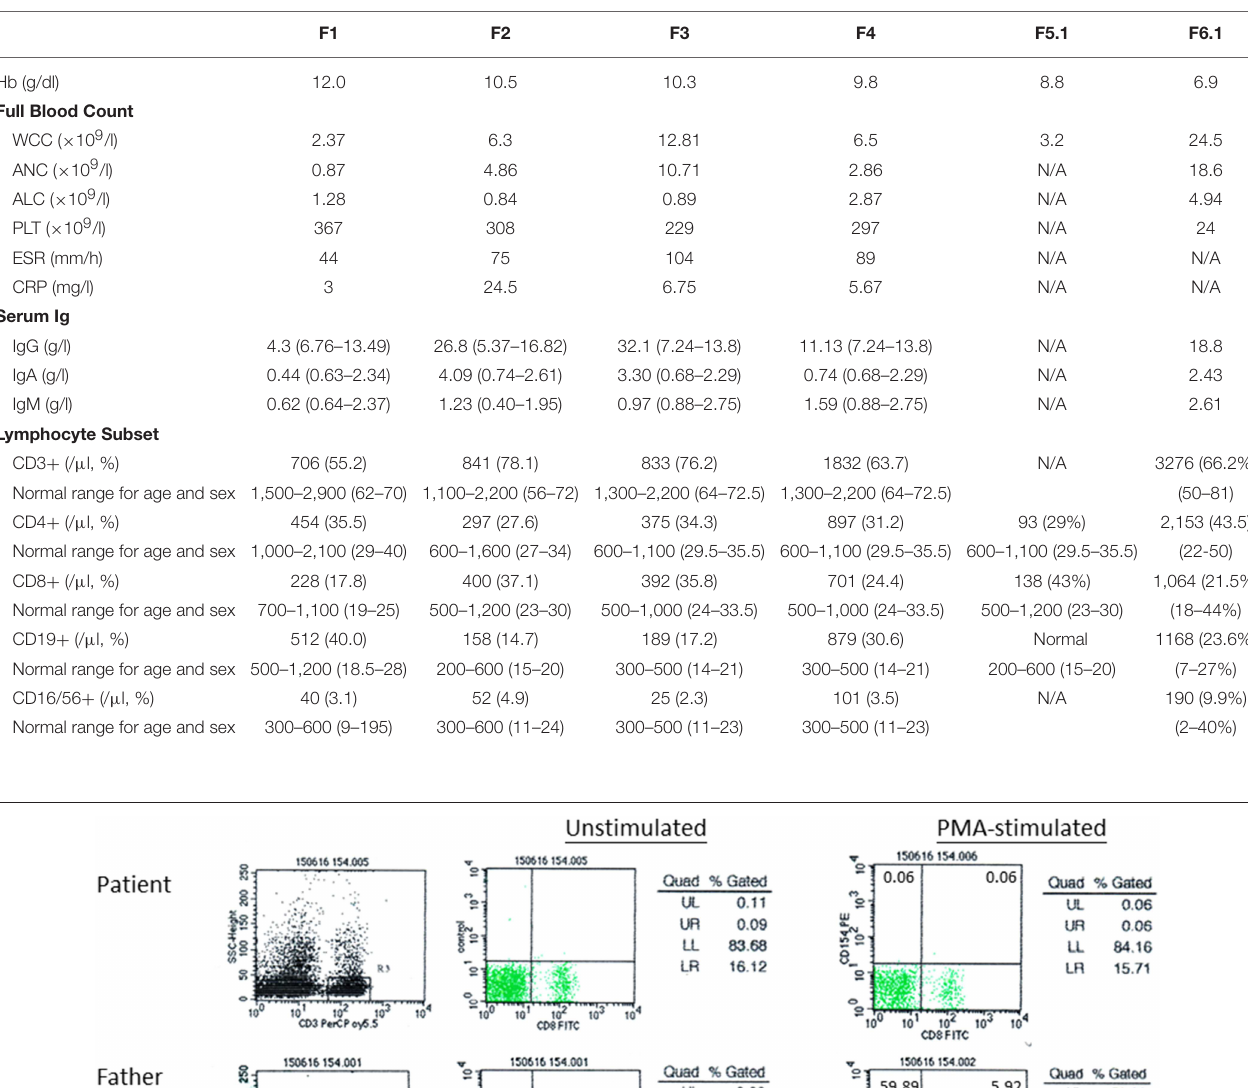
TABLE 1 | Hematological and immunological parameters.